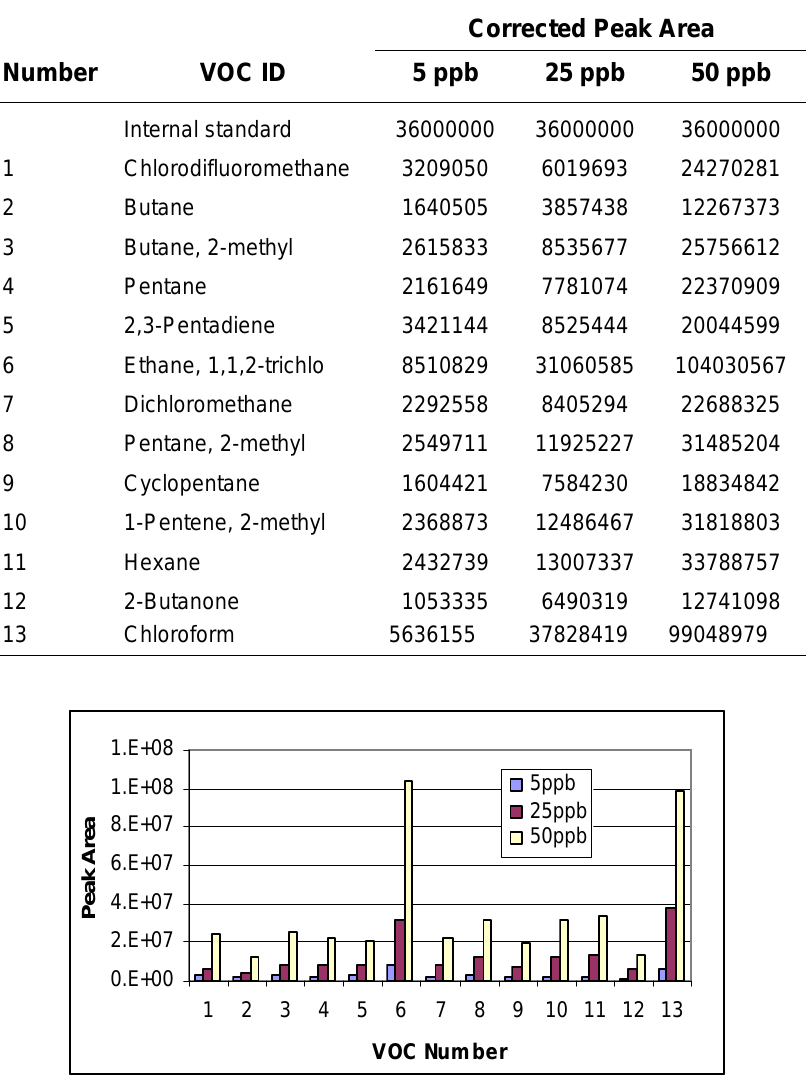
FIGURE 6 . Corrected VOC peak areas comparison at three-level concentrations.